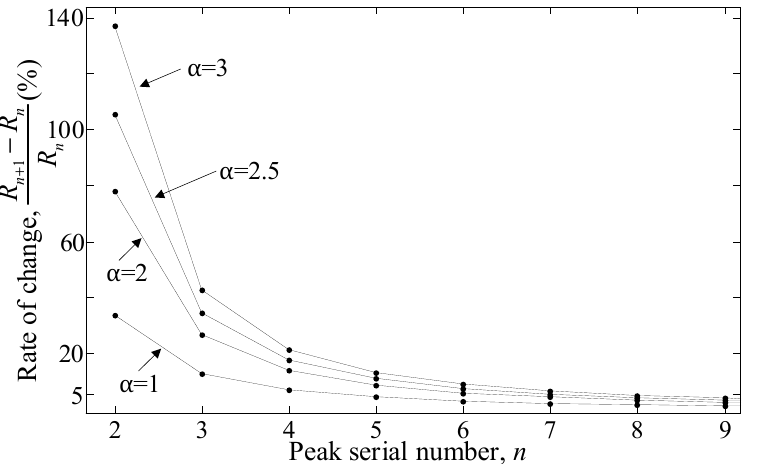
Figure 5. The rate of change of the value of the peak ratio characteristic value (PRCV). Obviously, for an ultrasonic signal, the corresponding relationship can be established between the value of the PRCV which is independent of the signal amplitude and the peak serial number through Equation (4), so that the peak serial number has the corresponding PRCV. Accordingly, the following definition is